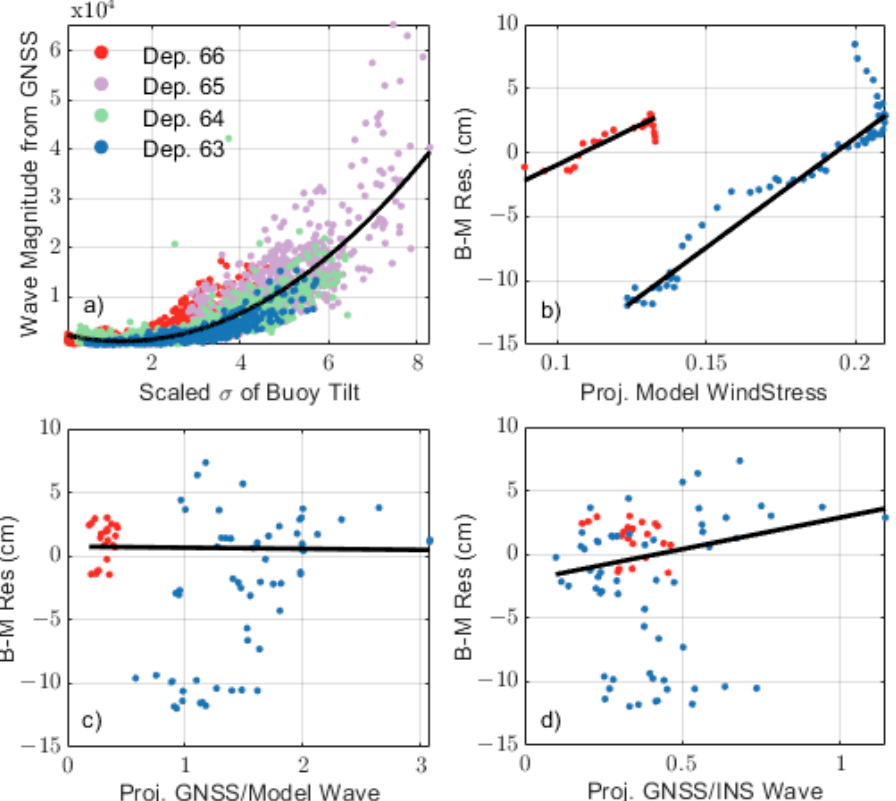
Figure 8. Relationship between buoy platform dynamics and wave metrics. In panel ( a ), the x-axis is windowed and scaled standard deviation of buoy tilt. The wave magnitude in the y-axis is defined as the power spectrum density extracted from GNSS derived SSH solutions as described in Section 3.2.3. Solid black line is a fitted quadratic model against wave magnitude derived from GNSS across all deployments; in panel ( b ), a relation between modelled wind stress projected onto the tether and B–M residuals over the selected low current & moderate wave period; panel ( c ) shows the relation between B–M residuals and quantities with modelled wind stress directions and GNSS derived wave magnitudes; panel ( d ) shows the relation between B–M residuals and quantities with INS derived directions and GNSS derived wave magnitudes. In ( b – d ), solid black line is the line of best linear fit. This specific alignment of the forcings lasted for ~5 h in total yielding 60 samples at 5-min interval for deployment 63, while it lasted for ~2 h in total with 24 samples at 5-min interval for deployment 66. Colouring for four deployments remain consistent as indicated by the legend in panel ( a ), note in panel ( b – d ), only samples from deployment 63 and 66 fit the criteria.